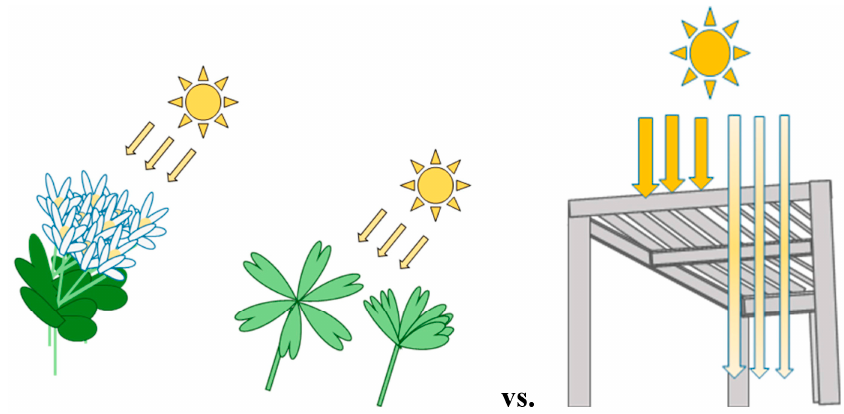
Figure 3. Example of responses for diaheliotropic and paraheliotropic plants and their relationship to adaptive shaping. Examples include bending of whole plant towards sun, orientation of leaves to either capture or avoid sunlight and an adaptive shading terrace whereby slats open to allow a portion of light to reach the ground.